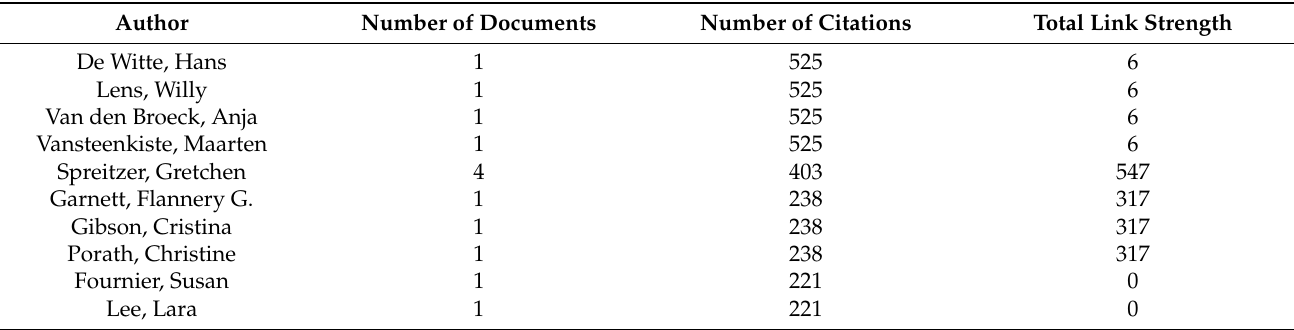
Table 4. The 10 most-cited authors in thriving at work, citations linked with others.